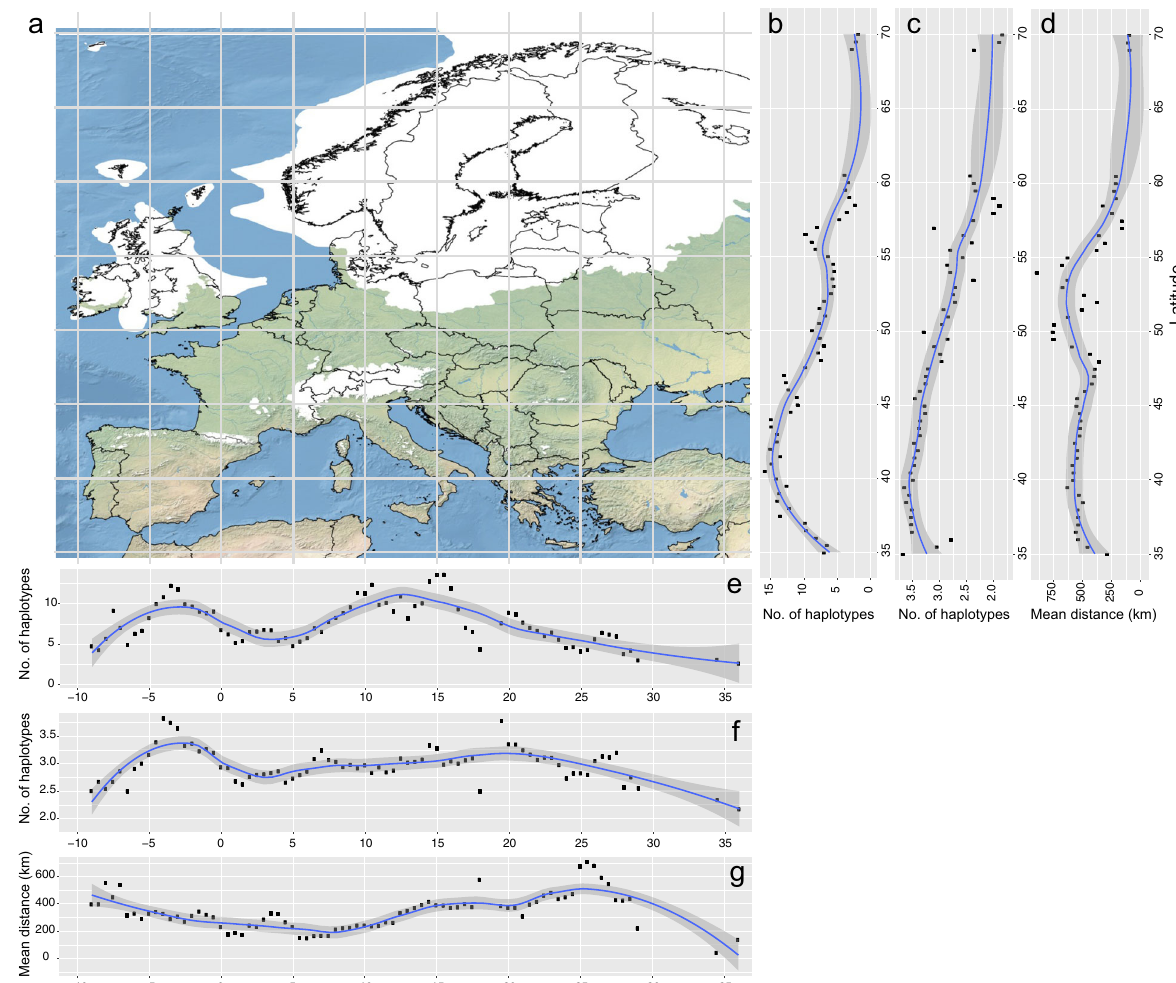
Fig. 3 Levels of mitochondrial DNA diversity for butter fl ies across Europe. a Map of Europe showing the extent of Pleistocene ice sheets (white areas); b – g Smoothed Conditional Means plot of haplotype richness using locally estimated scatterplot smoothing with a 95% con fi dence interval (shaded area); b Latitudinal trend in haplotype diversity based on the full dataset; c Latitudinal trend in haplotype diversity based on a random homogeneous subsampling of the full dataset; d Latitudinal trend of geographic distances among sampled specimens for the full dataset; e Longitudinal trend in haplotype diversity based on the full dataset; f Longitudinal trend in haplotype diversity based on a random homogeneous subsampling of the full dataset; g Longitudinal trend of geographic distances among sampled specimens for the full dataset. Latitude was divided into n = 65 belts and longitude was divided into n = 77